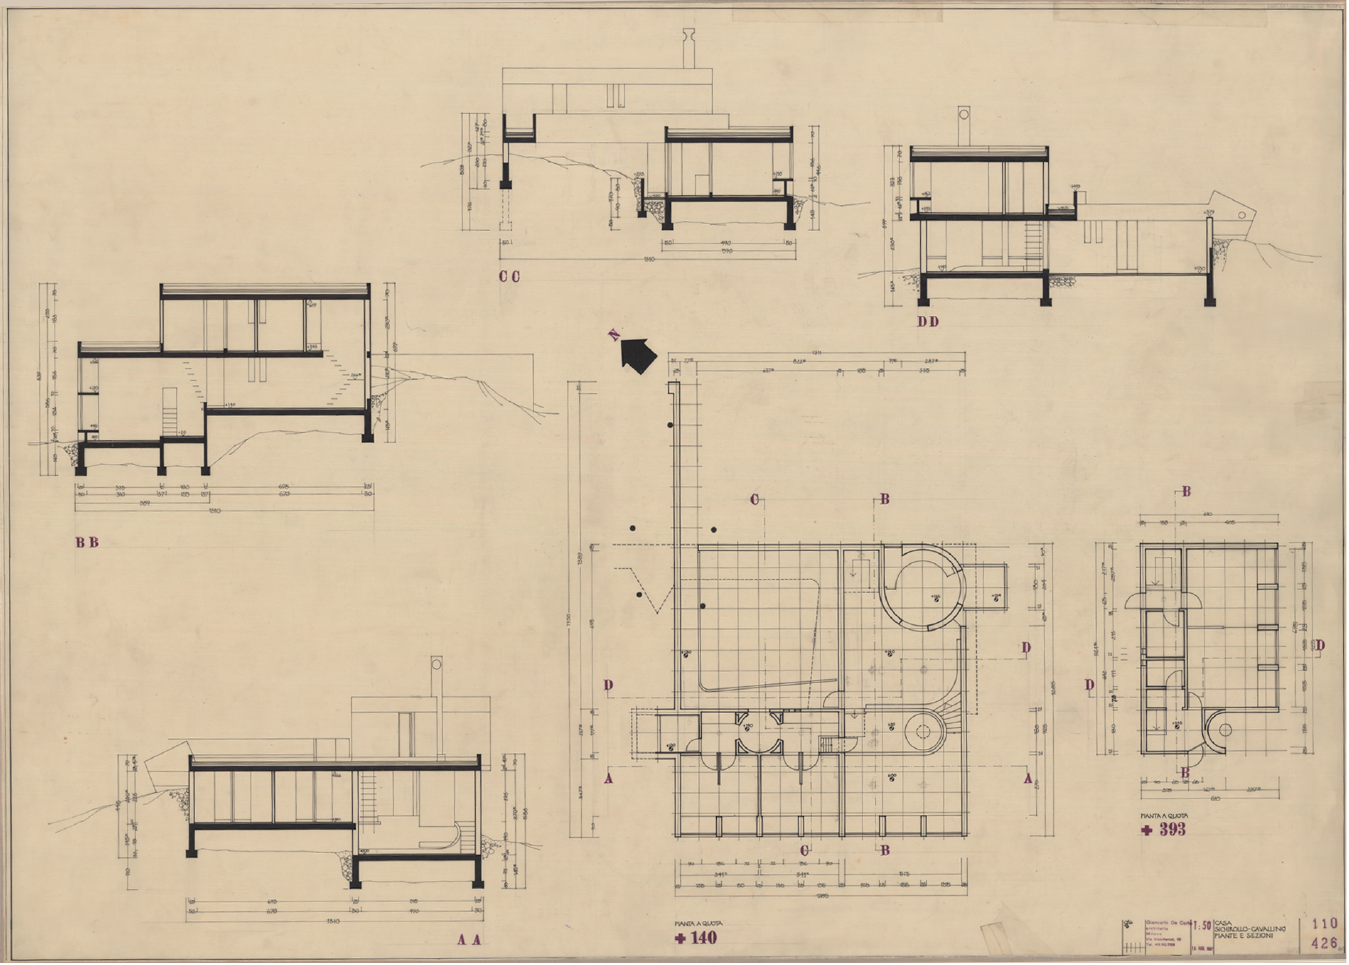
Plans and section of Casa